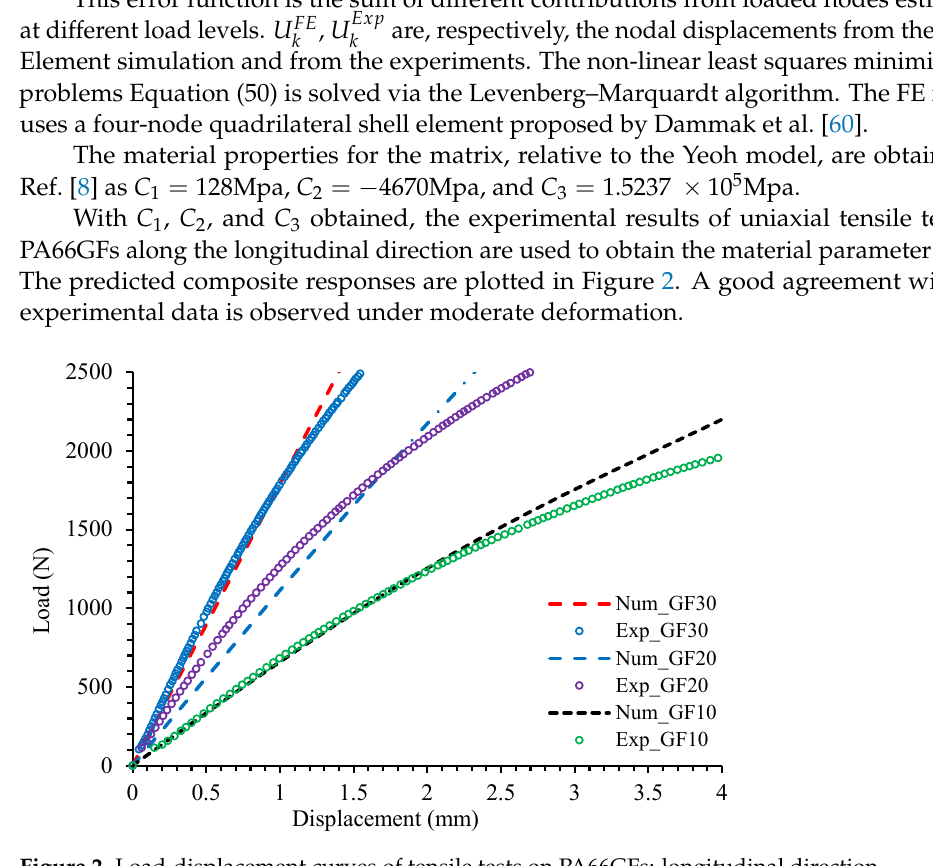
lastic model cannot be determined without additional experimental tests, such as shear